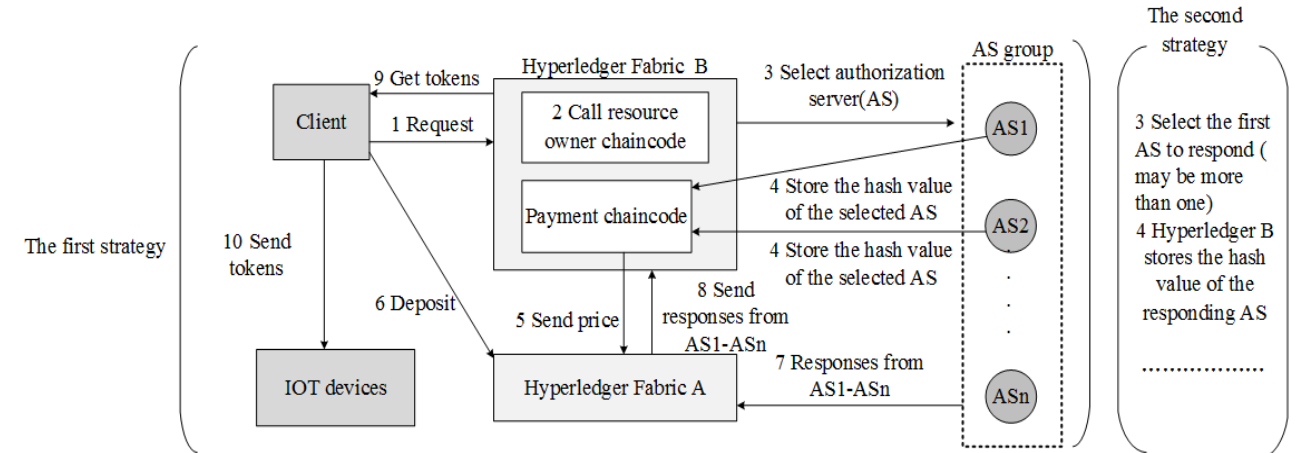
Figure 14. Reconstruction diagram of reference [37].